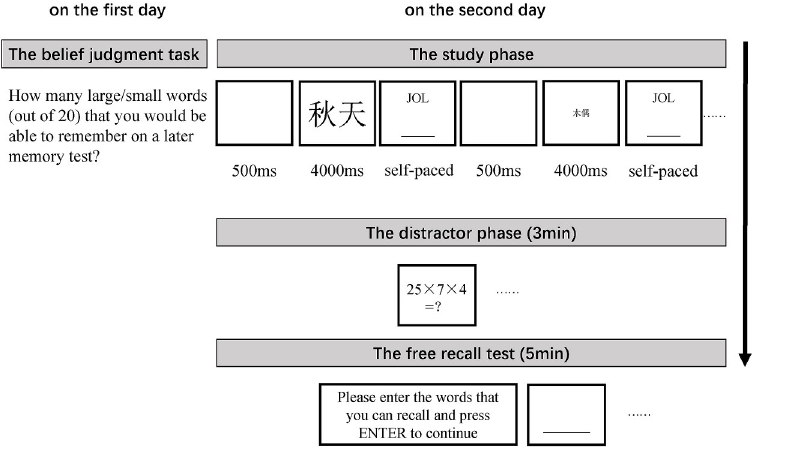
Fig 1. Experimental procedure for Experiment 1.